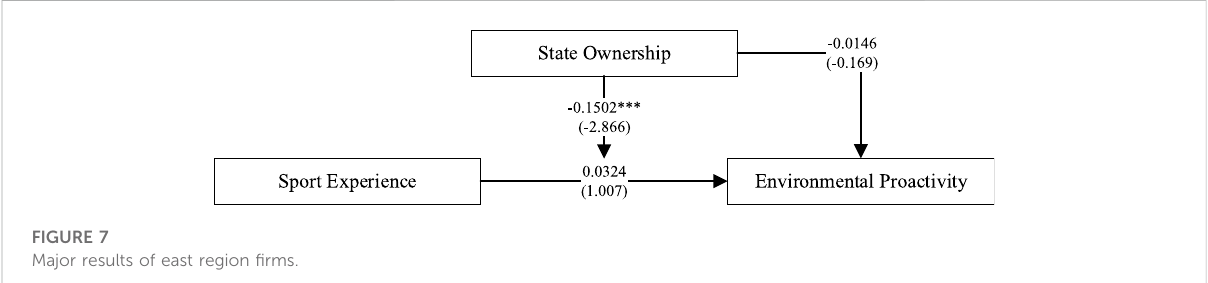
FIGURE 7 Major results of east region fi